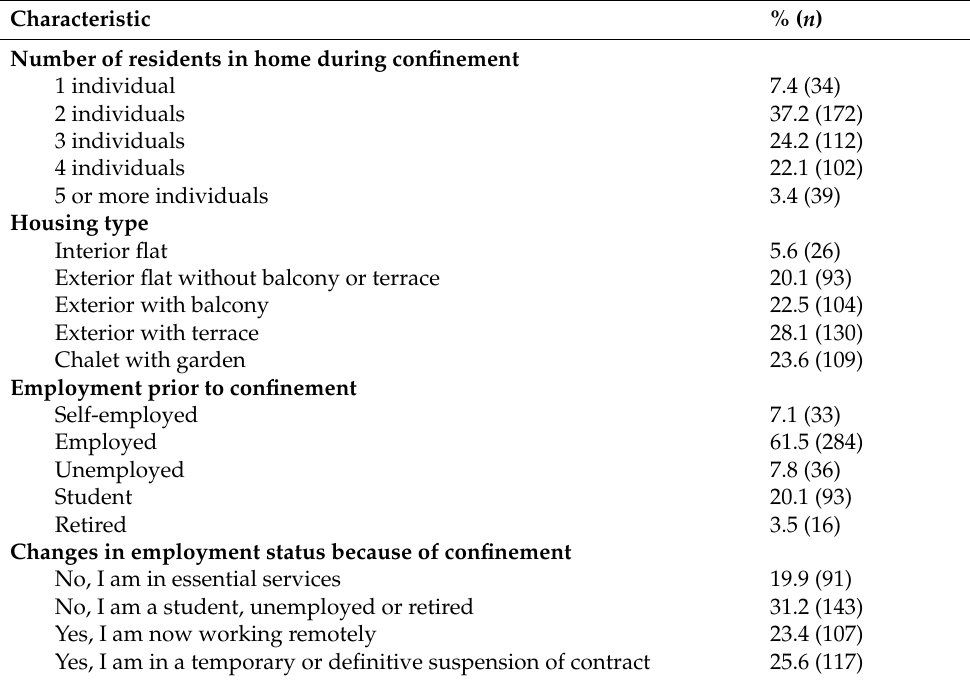
Table 1. Sociodemographic characteristics.